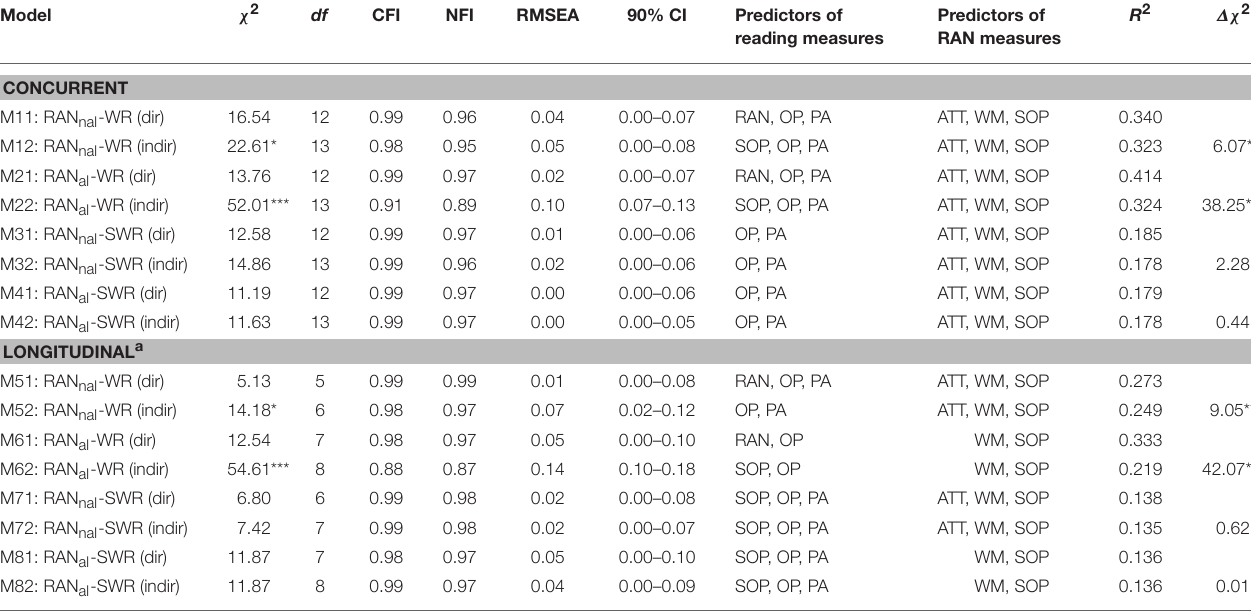
TABLE 3 | Fit Indices for Models of Concurrent and Longitudinal